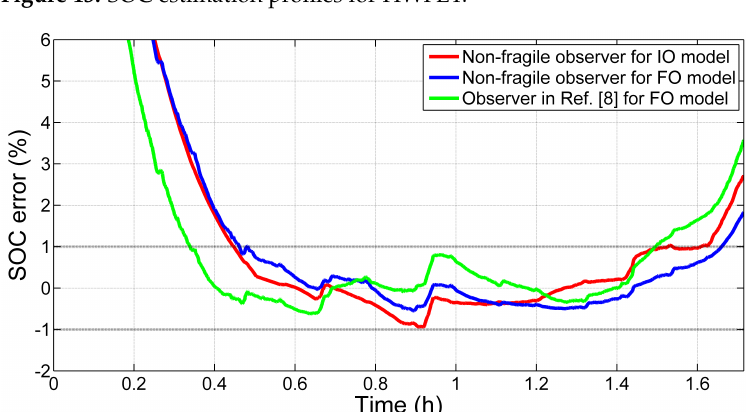
Figure 14. SOC estimation error profiles for